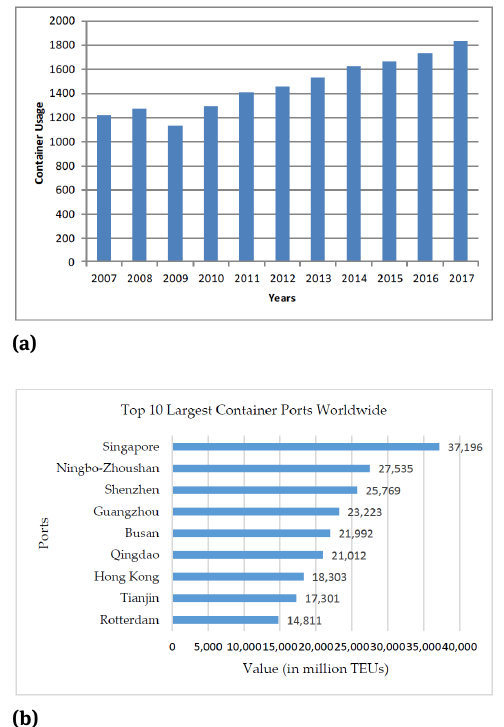
Figure 2: (a) Shipping container usage from UNCTAD [11]; (b) Top 10 largest container ports worldwide from Marine